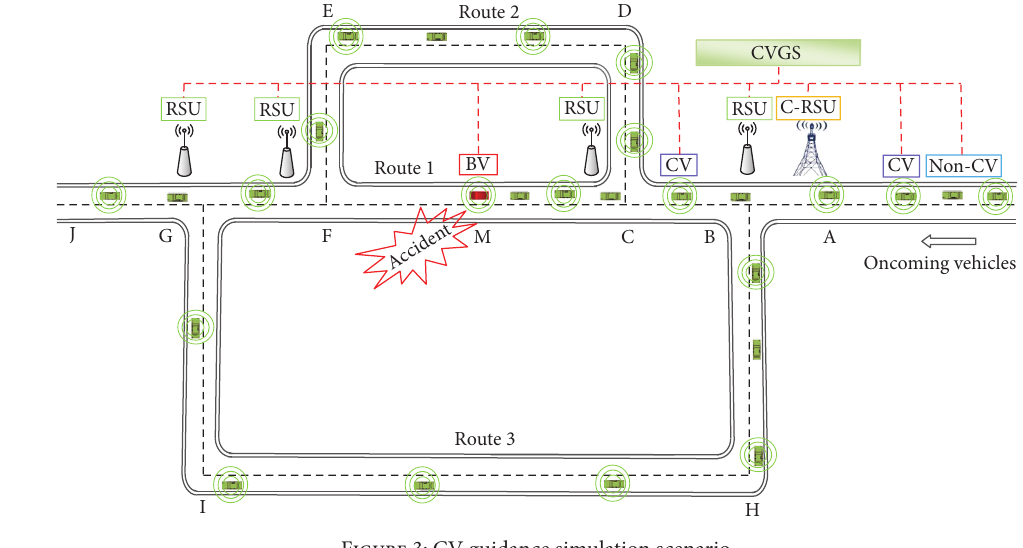
Figure 3: CV guidance simulation scenario. Table 1: Basic parameters of the